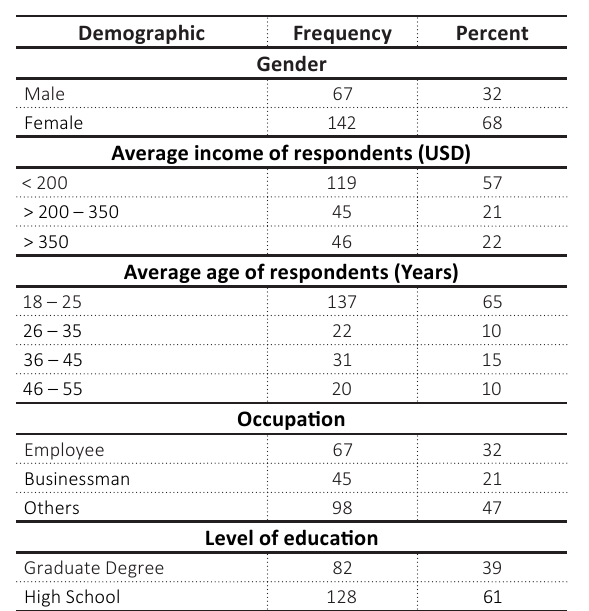
Table 2. Sample characteristics of consumer